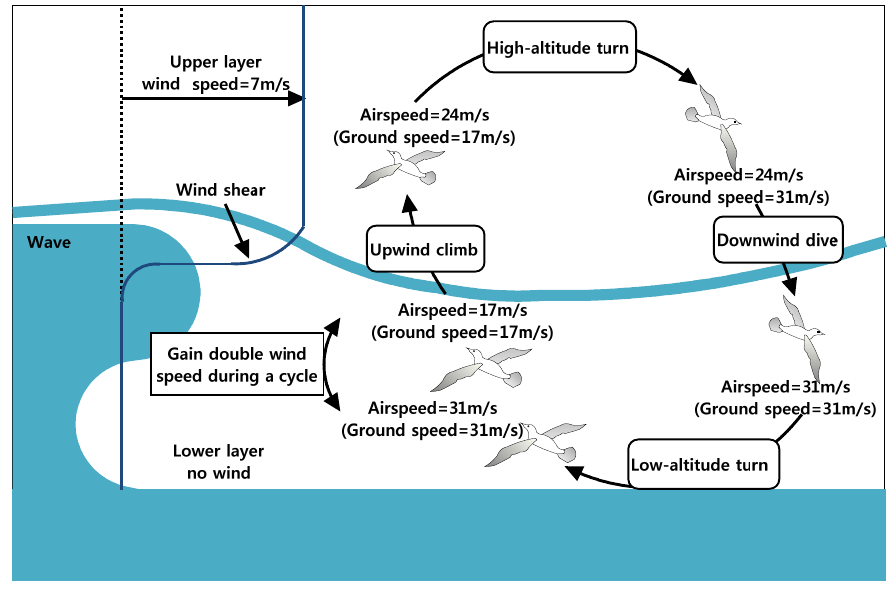
Figure 4. Illustration of a typical Rayleigh cycle.